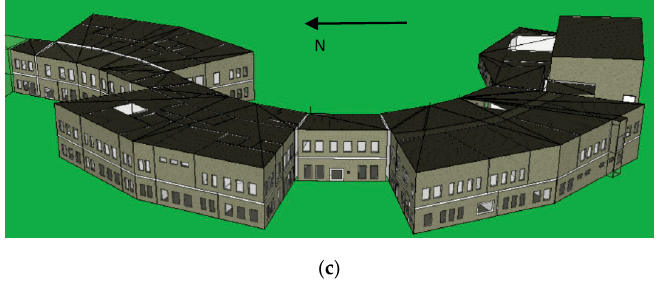
Figure 1. Three-dimensional (3D) view of ( a ) School S; ( b ) School N; ( c ) School B according to the IDA ICE model.